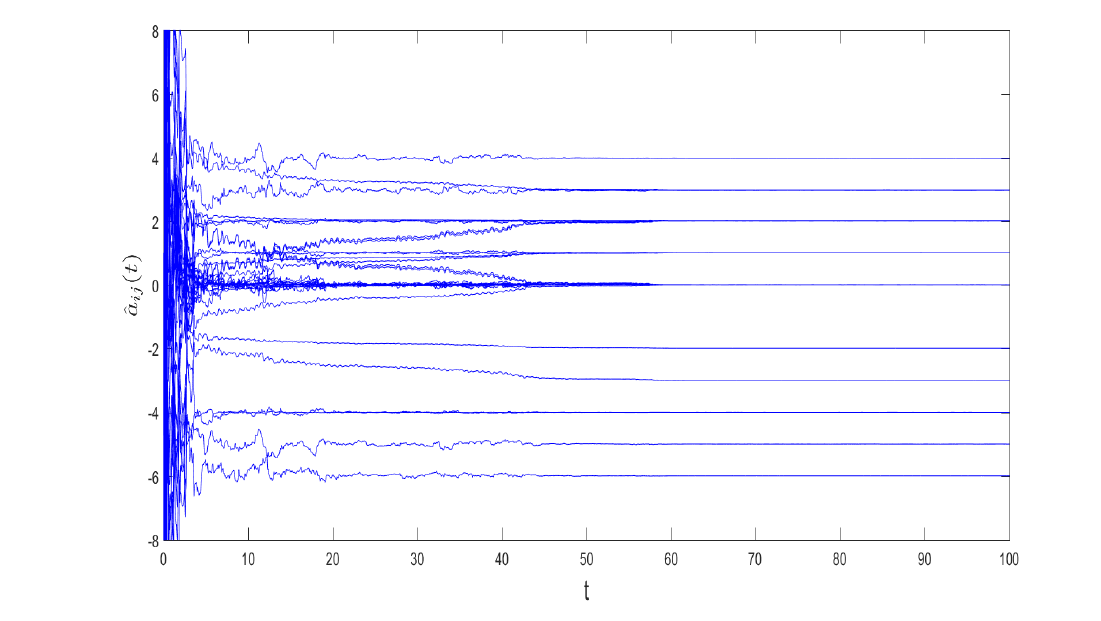
Figure 1. The evolution of (cid:98) a ij ( t ) , i , j = 1,2, . . .